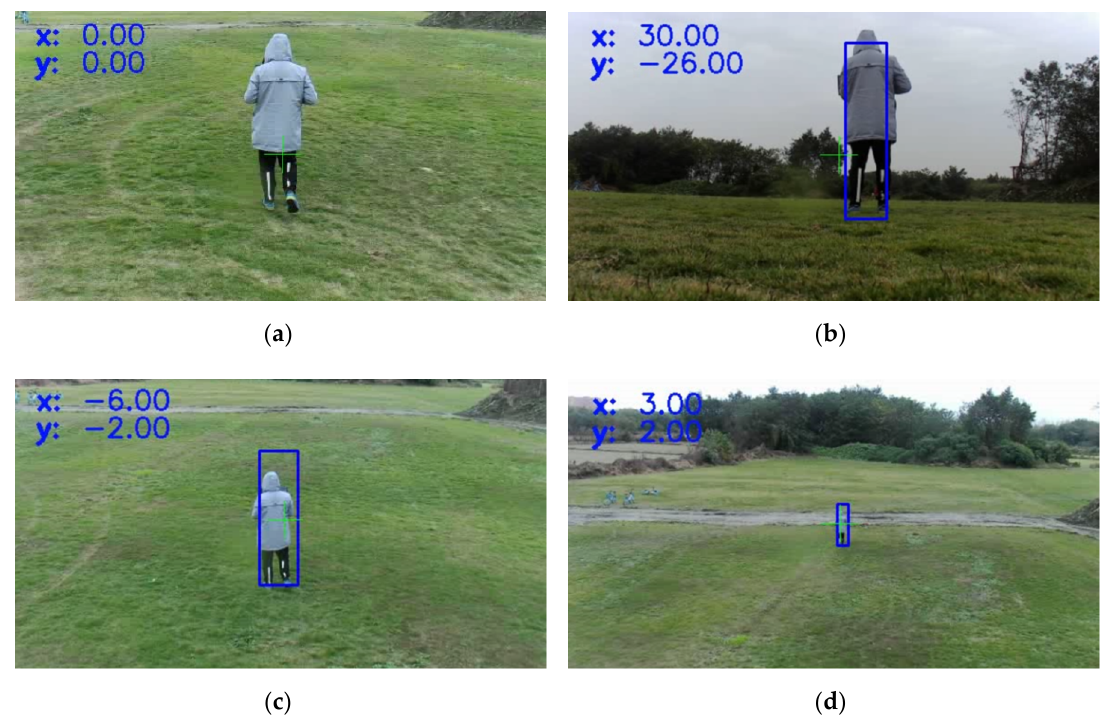
Figure 10. Tracking of a human target moving at pedestrian speed. ( a ) video streams with no target selected; ( b ) tracking of the selected target with its error pixels displayed on screen; ( c ) autonomously lock on the target in close range using the gimbal system; ( d ) real-time adjustment to the scale changes of the target.